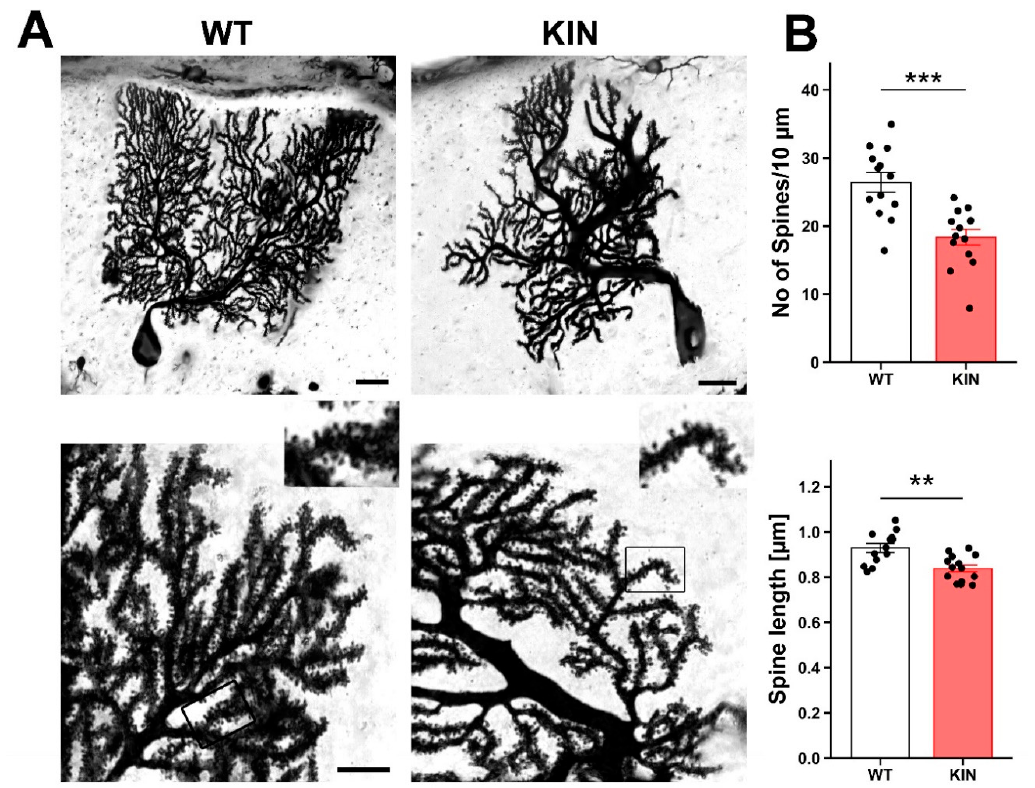
Figure 6. Golgi impregnation of Purkinje cells in WT and Atxn2 -CAG100-KIN cerebella at pre-terminal age of 9 mo. ( A ) Representative images of Purkinje neurons of both genotypes in low and high magnifications. Scale bars indicate 20 μ m (upper row) and 10 μ m (lower row); in order to be able to appreciate differences in spine length and spine density, an inlet was added showing a dendritic segment at higher magnification. This image is a digital zoom-in at a factor of 2. It can be clearly seen that the density is much less in KIN mice, while the spine length is a little smaller. ( B ) Significant reductions of spine number and length were observed in Atxn2 -CAG100-KIN Purkinje dendrites compared to WT ( n = 13 WT vs. 14 KIN Purkinje cells, from 4 WT vs. 3 KIN animals). Levene’s test was used for evaluating equal data distribution, and ANOVA equals t -test was used to compare WT vs. KIN cells; p < 0.01 **, p < 0.001 ***. Further information regarding individual fold changes and p -values can be found in Supplementary Table S3.